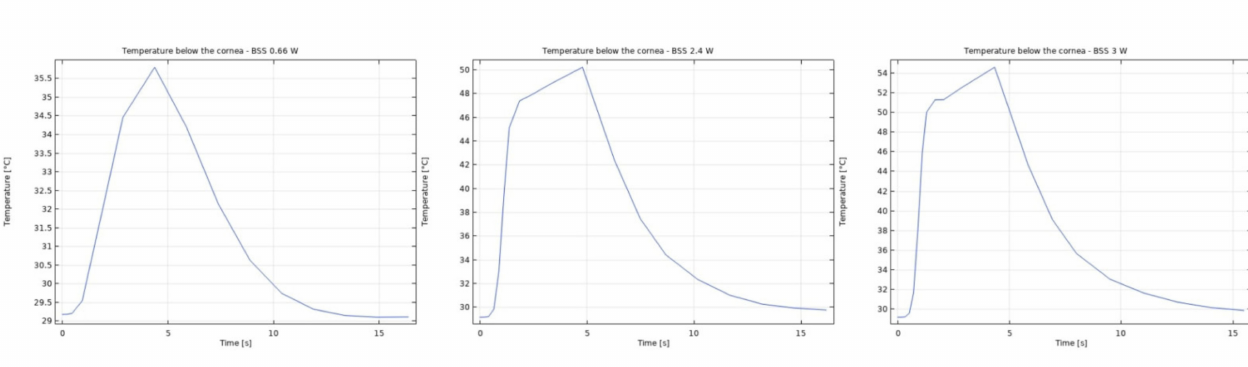
Figure 9. Temperature distributions with BSS after 5 s of 0.66 W, 2.4 W and 3 W impulse.